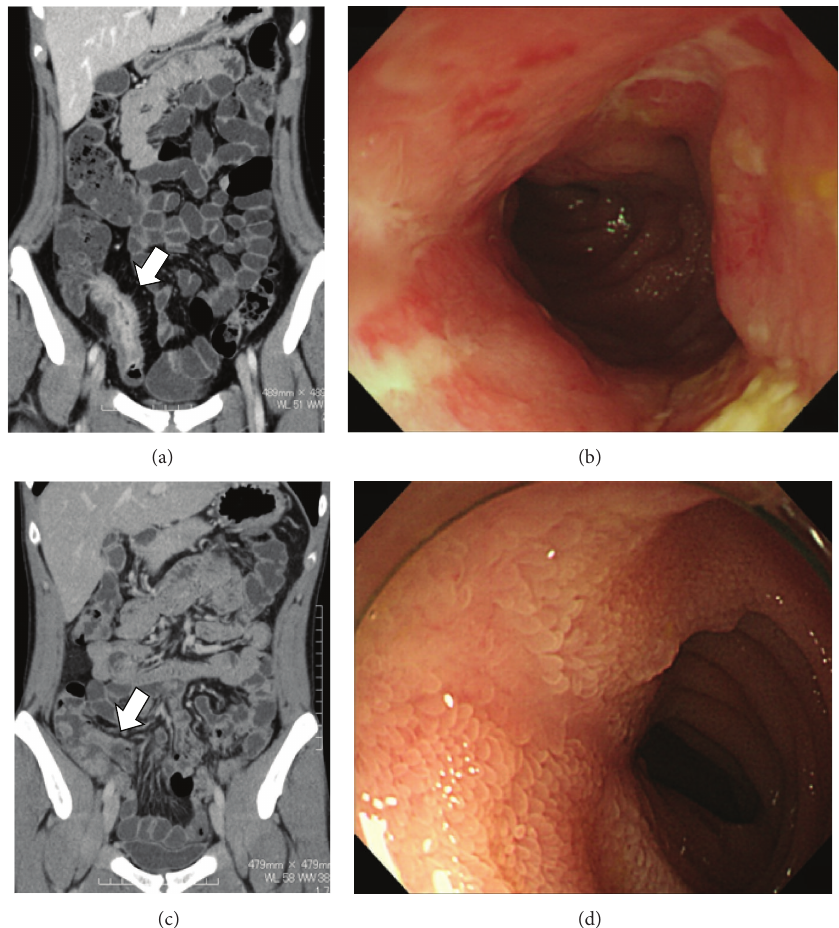
Figure 1: Findings from CT enteroclysis/enterography and endoscopic mucosal examination. (a) CT enteroclysis/enterography findings from a patient in the active group show small bowel wall thickness, wall enhancement, and presence of an increase in the concentration of fat tissue surrounding the intestine. (b) Mucosal findings corresponding to the same location as indicated by the arrow in (a) show edema and ulcer. (c) CT enteroclysis/enterography findings from a patient in the inactive group show only slight small bowel wall thickness. (d) Mucosal findings corresponding to the same location as indicated by the arrow in (c) show only an ulcer